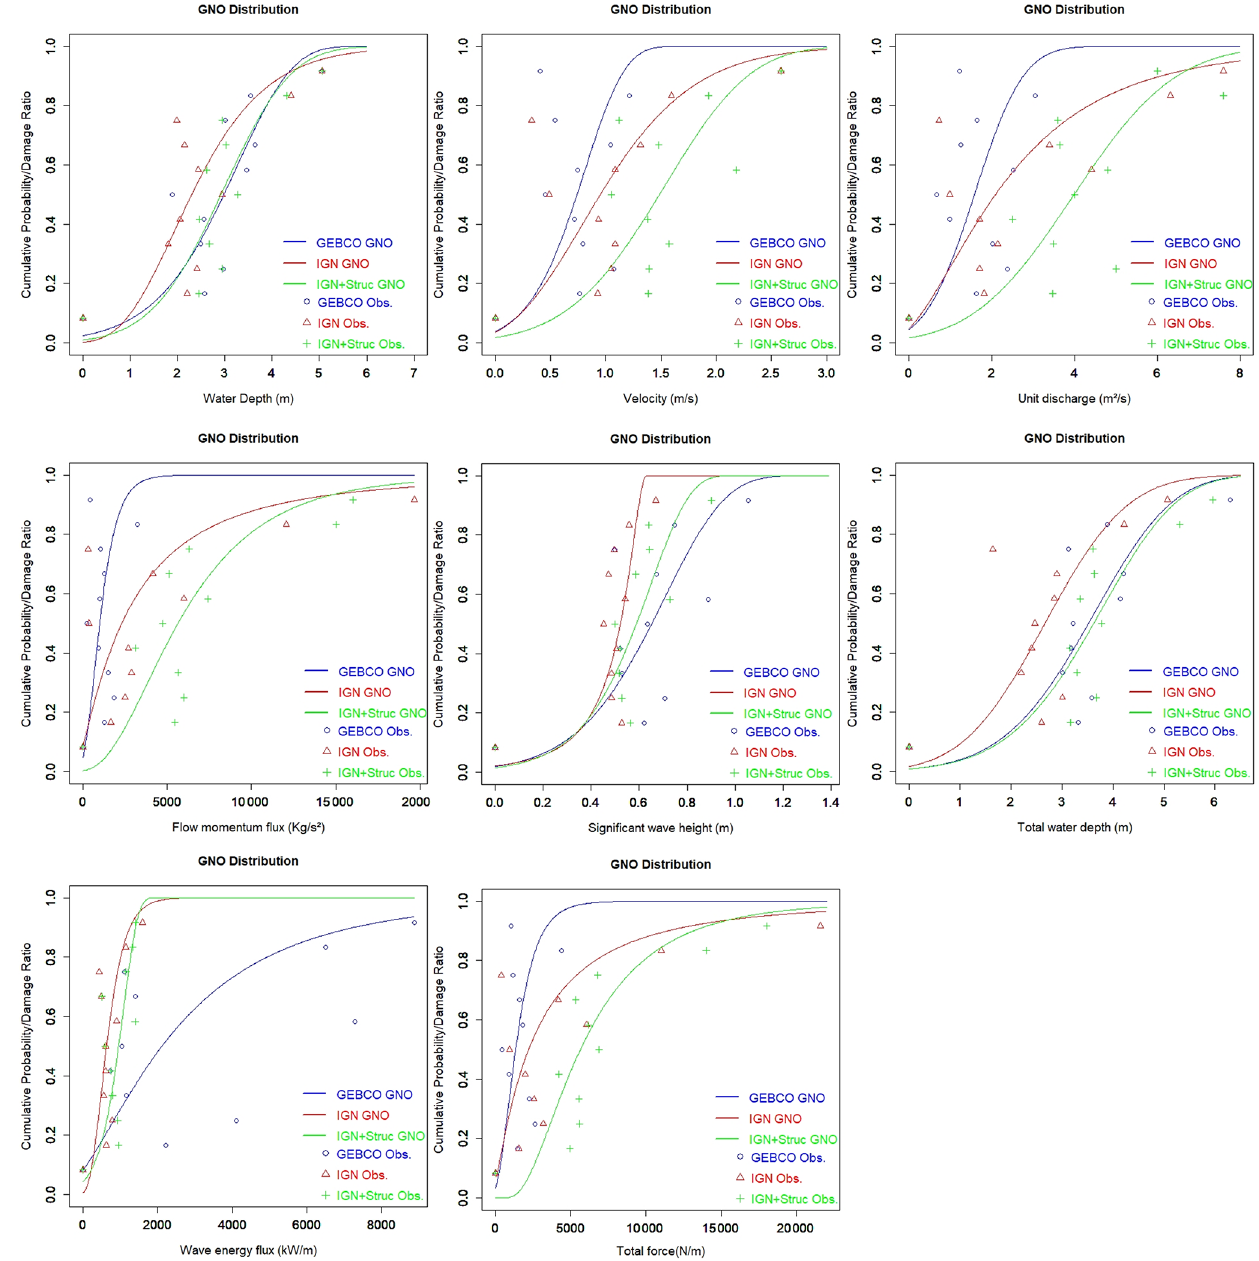
+ ρhv 2 ) and different C g